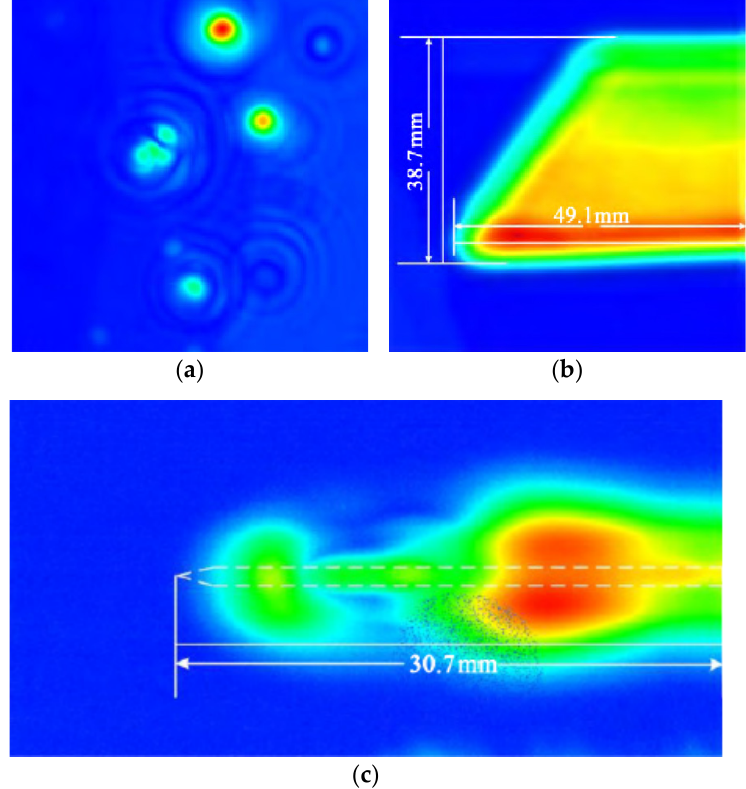
Figure 16. Ultrasonic testing results graph [69]. ( a ) Bubble defect detection result; ( b ) Air gap defect detection result; ( c ) Steel needle defect detection result.